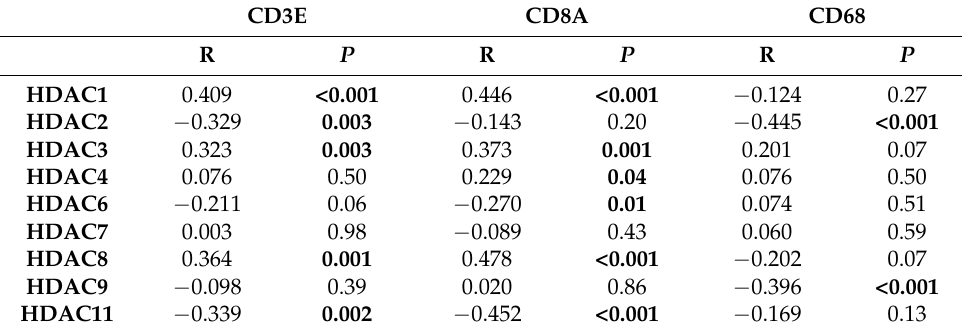
Table 4. Correlation between mRNA expression levels of different HDACs and expression of TILs (CD3E and CD8A) and TAMs (CD68) in the TCGA cohort ( n = 80). R = two-tailed Spearman correlation coefficient. p ≤ 0.05 is considered significant (indicated in bold). CD3E